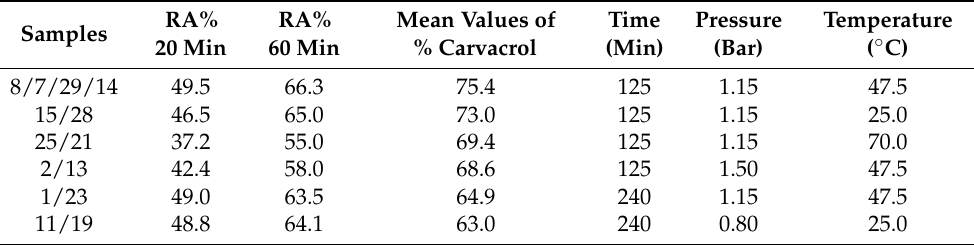
Table 5. Antioxidant activity (mean values of RA% values) in correlation with the mean % values of carvacrol content and with the distillation process factors